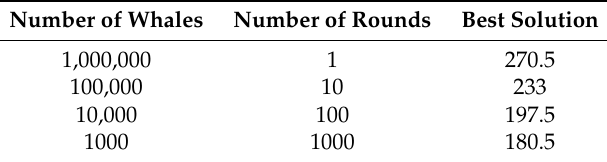
Table 10. The best solution of DS 1 for di ff erent modes.